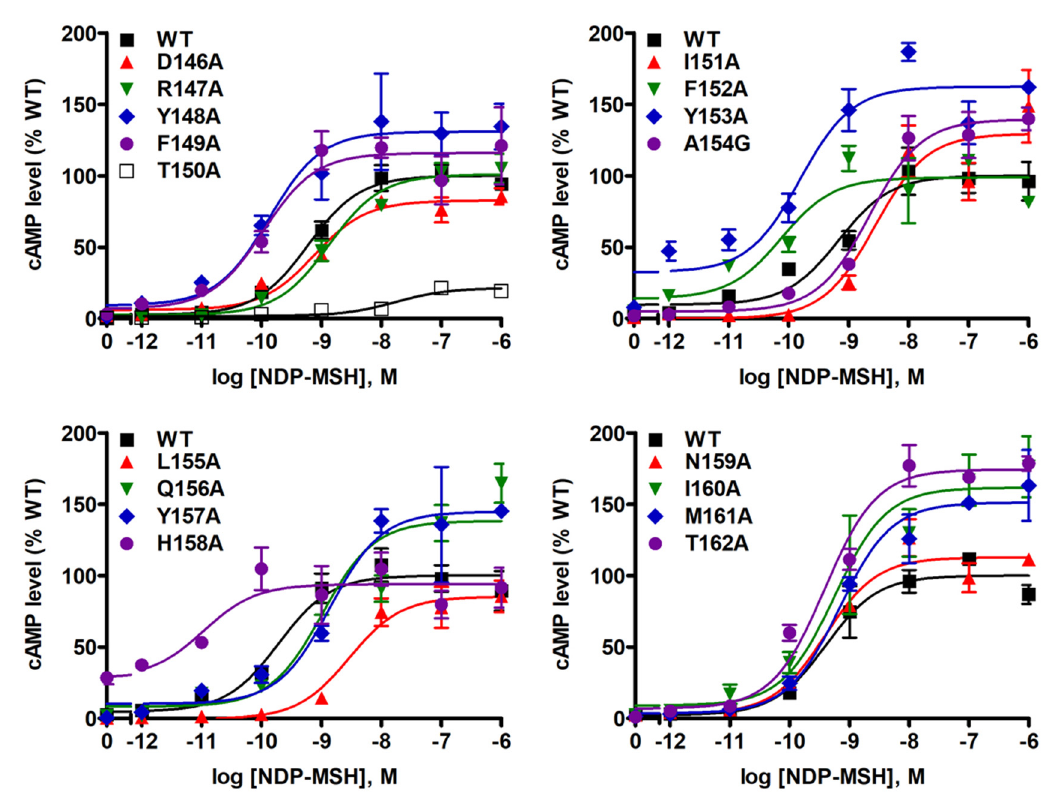
Figure 5. NDP-MSH-stimulated cAMP signaling properties of WT and mutant MC4Rs. HEK293T cells were transiently transfected with WT and mutant MC4Rs, and intracellular cAMP levels were measured by RIA after stimulation with different concentrations of NDP-MSH. Results are expressed as % of WT maximal response ± S.E.M. of triplicate measurements within one experiment. Curves are representative of at least three independent experiments.